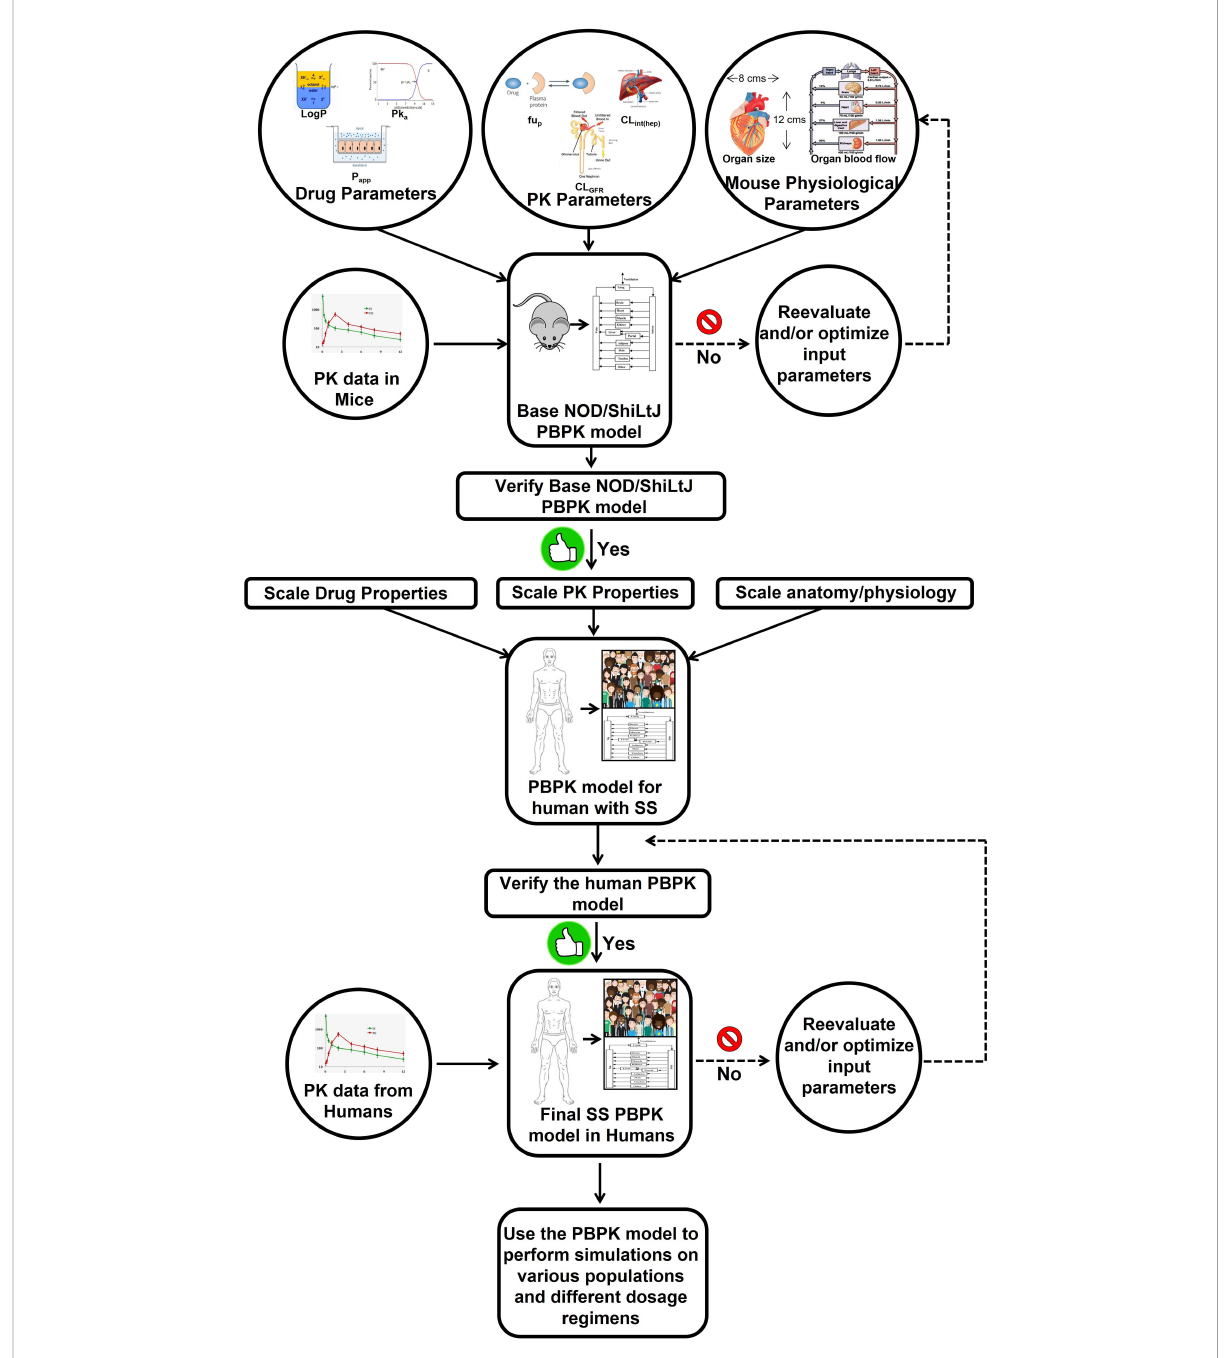
FIGURE 2 Work fl ow of PBPK model development for the specialized pro-resolving lipid mediator AT-RvD1. The PBPK model for human with Sjögren ’ s syndrome refers to the virtual population of the subjects whose anatomical physiological parameters are consistent with disease features. If the model-predicted data does not agree with the observed experimental data, a parameter identi fi cation and optimization will be performed using the default tools provided by the PK-Sim ® software to identify the parameter responsible for the lack of accurate predicts and then its value will be optimized using the observed data until a goodness of fi t is achieved between predicted versus observed data. Although AT-RvD1 is the subject of the fi gure, the same model can be applied to other specialized pro-resolving lipid mediators. This image was adapted from (163). AT- RvD1: aspirin-triggered resolvin D1; PBPK, physiologically based pharmacokinetic; PK, pharmacokinetics; SS, Sjögren ’ s